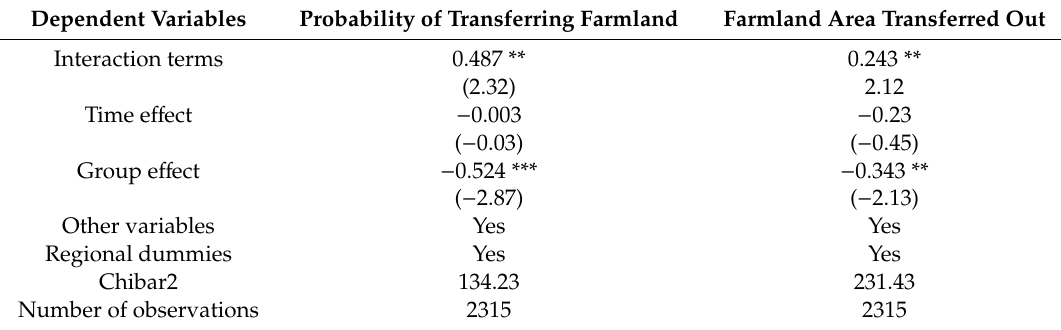
Table 7. Robustness test of the results of DID